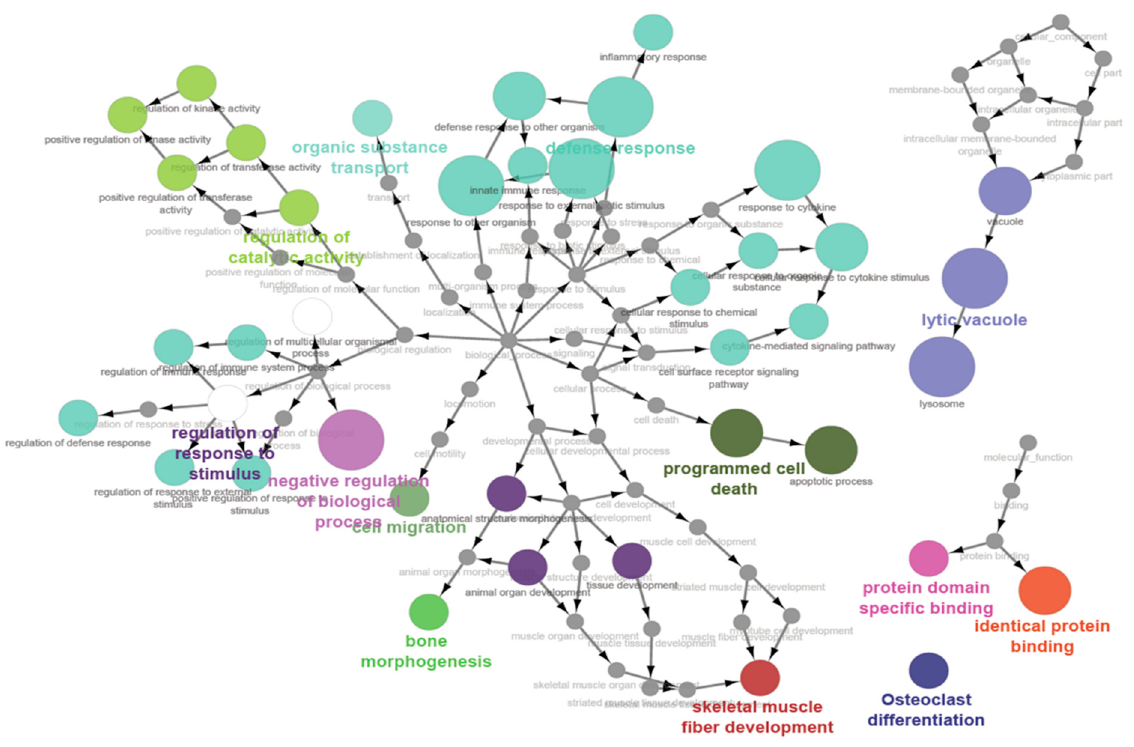
Figure 3. Functional network inferred from the gene ontology (GO) terms enriched in genes differentially expressed from the four contrast groups. The size of the circle indicates the number of genes associated with that GO term.